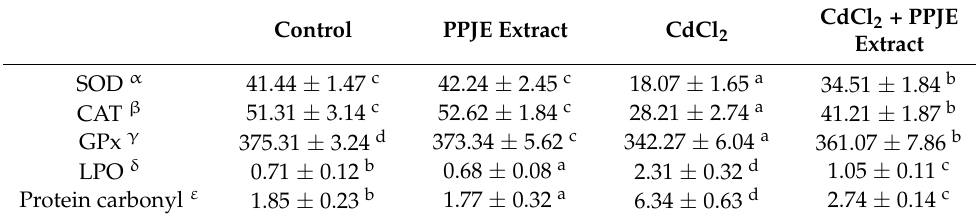
Table 5. Antioxidant enzyme activities and stress biomarkers levels in kidney tissue of the studied groups. Control rats. PPJE extract (250 mg/kg)-treated rats. CdCl 2 (1 mg/kg)-treated rats. CdCl 2 + PPJE extract (250 mg/kg)-treated rats. α : U mg − 1 protein; β : µ moles/H 2 O 2 consumed min − 1 mg − 1 of protein; γ : nmoles GSH min − 1 mg − 1 of protein; δ : nmoles of MDA g − 1 of tissue; ε : nmoles mg − 1 of protein.